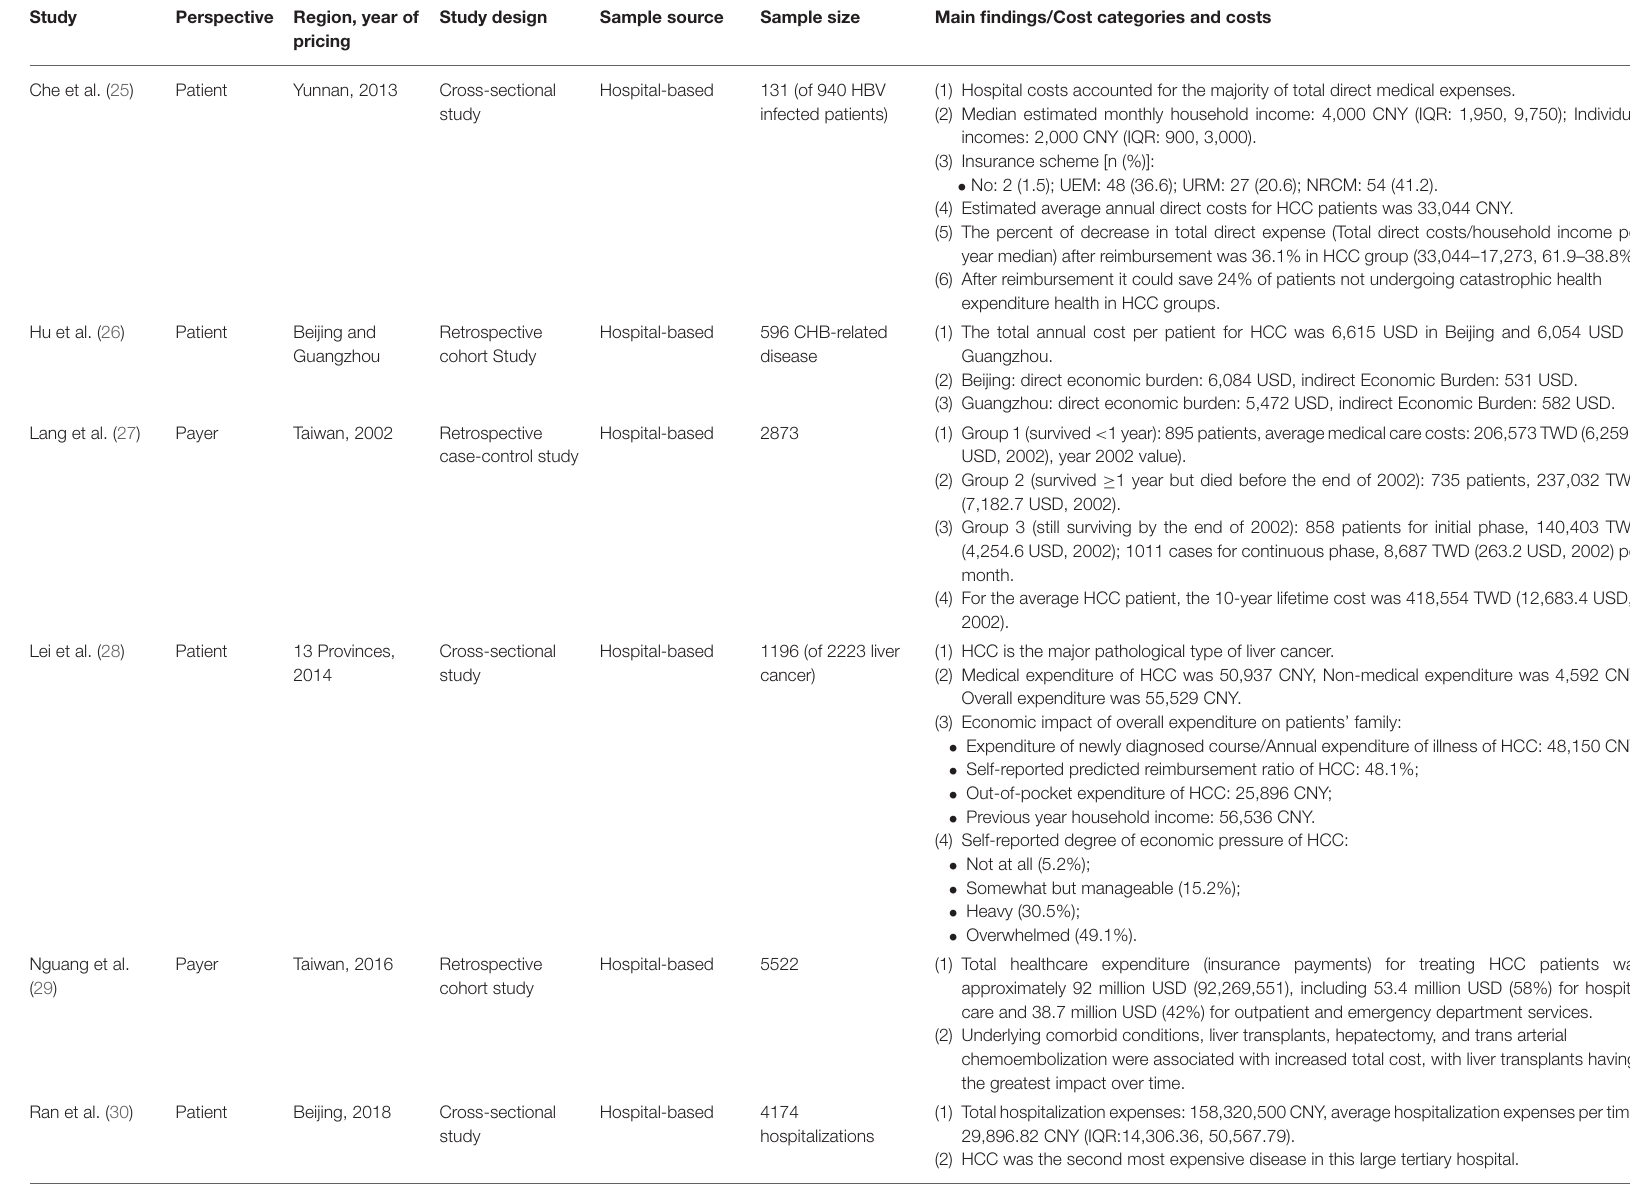
TABLE 3 | Characteristics of selected healthcare economic burden